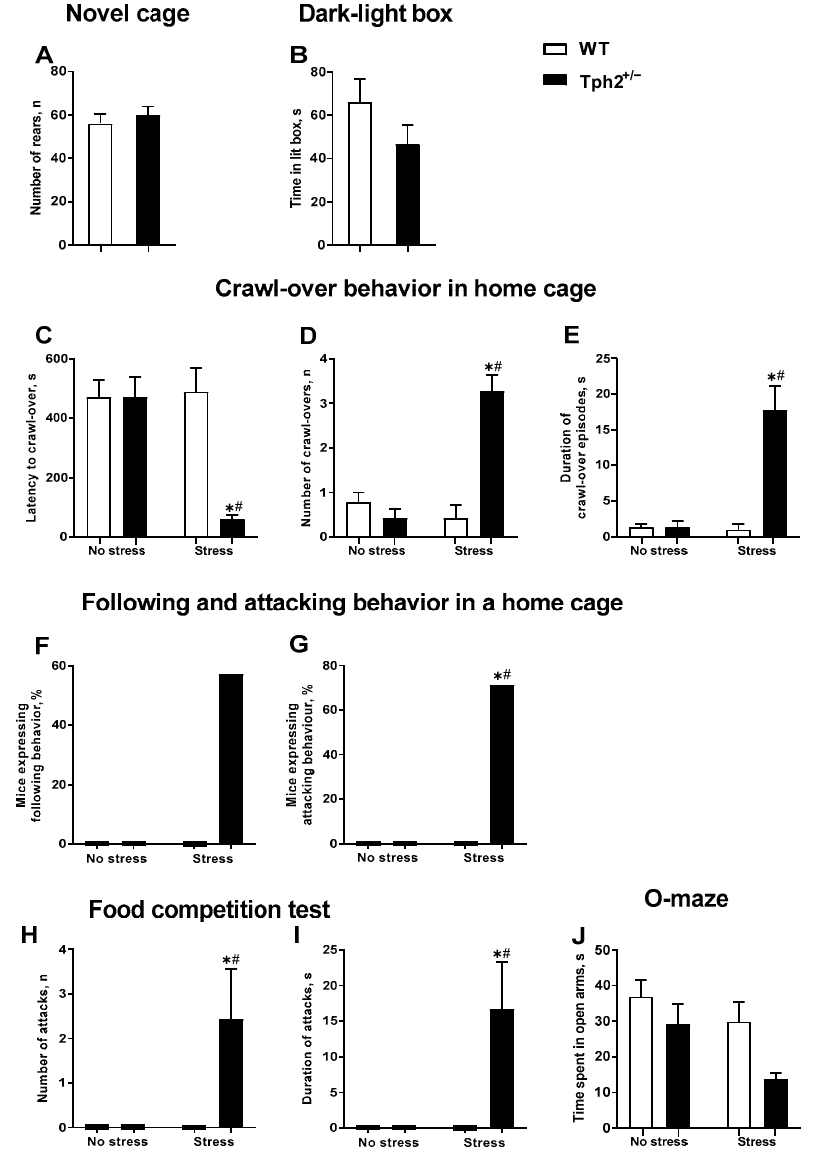
Figure 2. Behavioral features of naïve and stressed Tph2 +/ − female mice. ( A ) No alteration in the exploratory behavior of naïve Tph2 +/ − mice was found in the novel cage test and ( B ) in the time spent in the lit box (controls: n = 14, mutants: n = 10). ( C ) Significantly lower latency to crawl-over, significantly elevated number of crawl-overs ( D ), and duration of crawl-over behavior ( E ) in the social interaction in the home cage were present in the stressed Tph2 +/ − group. ( F ) There was no significant group difference in the percentage of the animals exhibiting the following behavior in social interactions in the home cage. ( G ) In social interactions in the home cage, agonistic